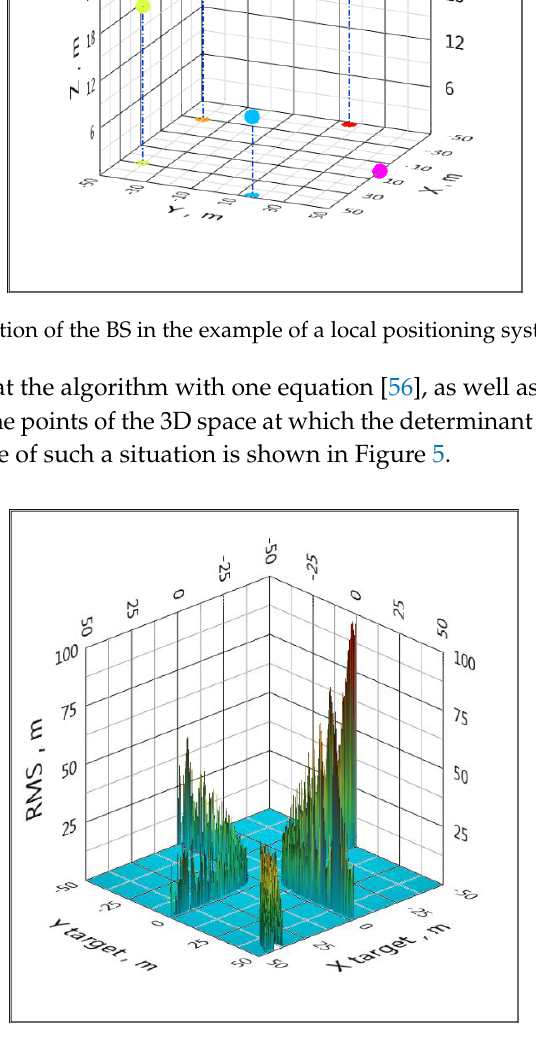
Figure 6. The distribution of the RMS (1 femtometer (fm) = 10 −15 m) coordinate estimate over the area when Gaussian noise is added to the TDoA values with a standard deviation of 0 ps (LPS).